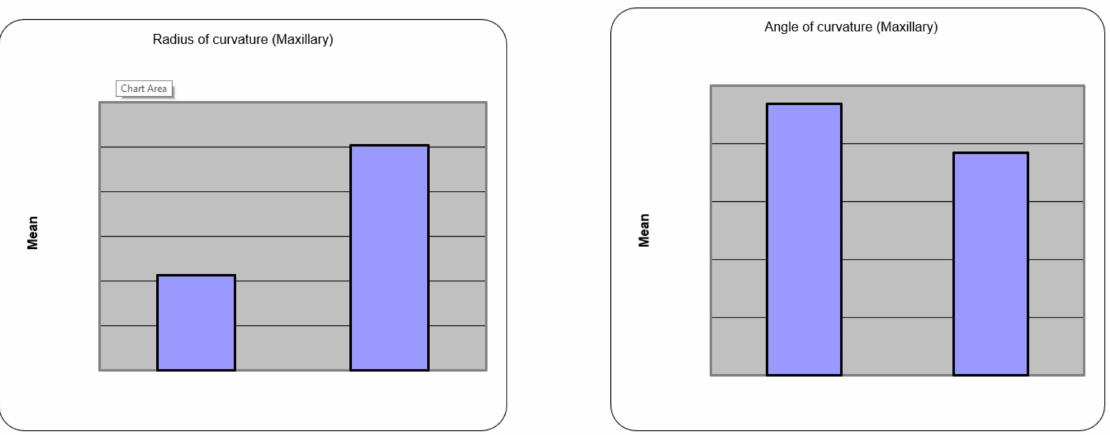
Figure 5. Radius of curvature, angle of curvature